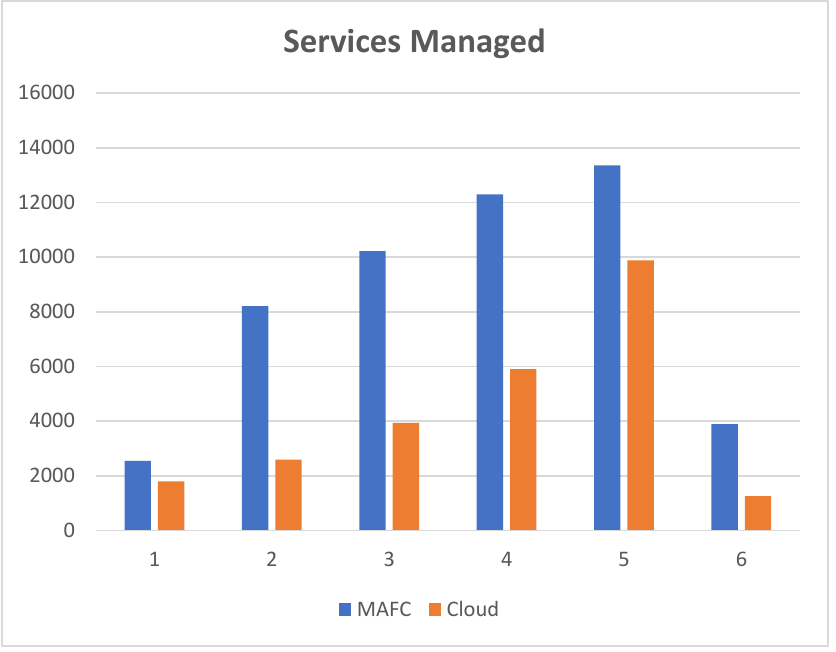
Figure 9. Services managed by the MAFC model and Cloud datacenters.